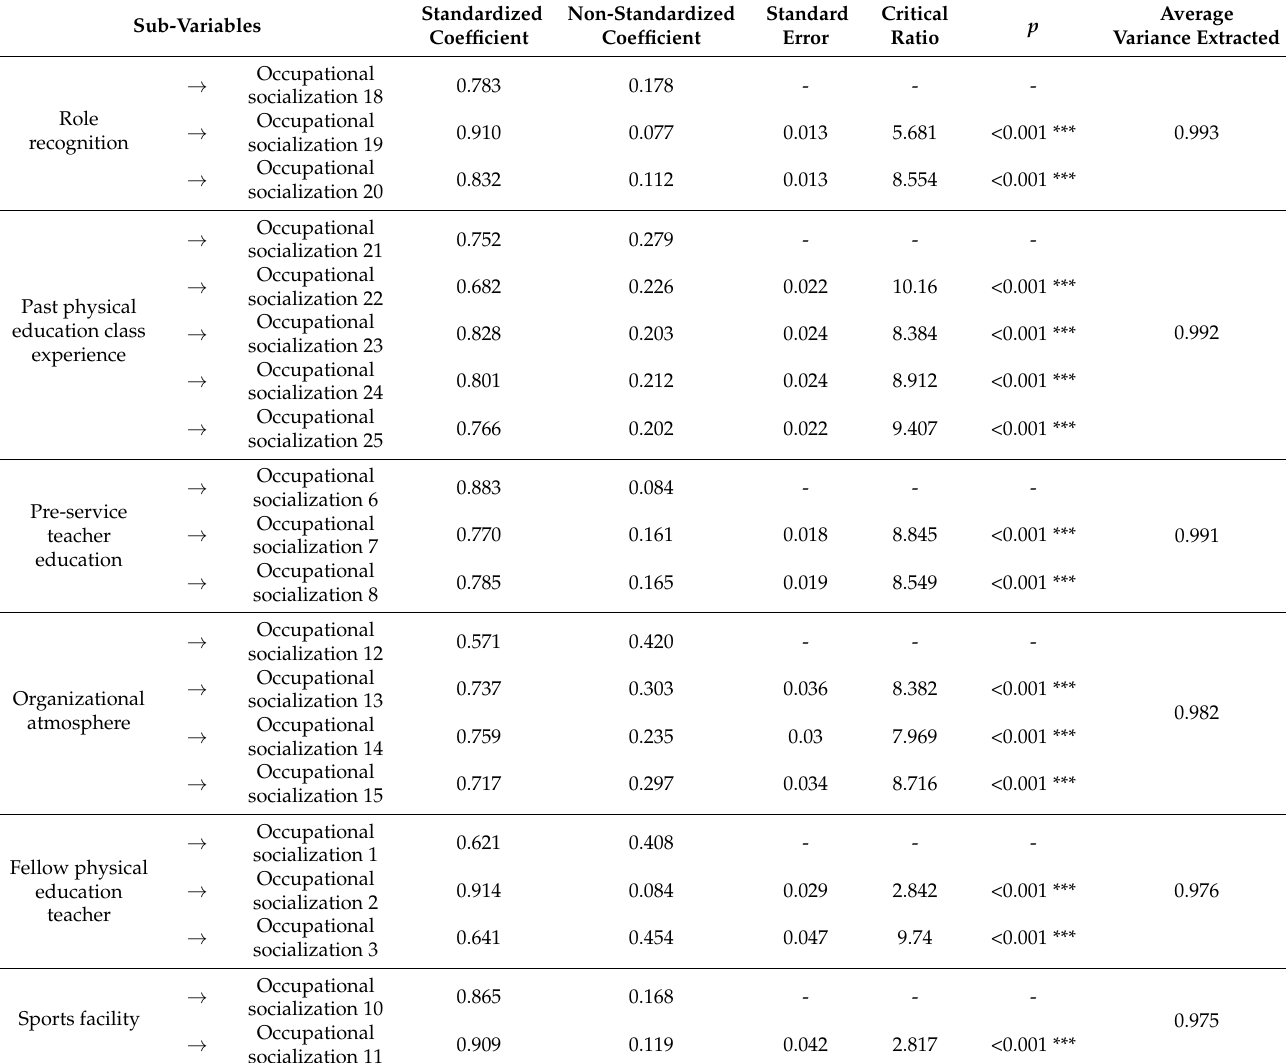
Table 4. Results of the confirmatory factor